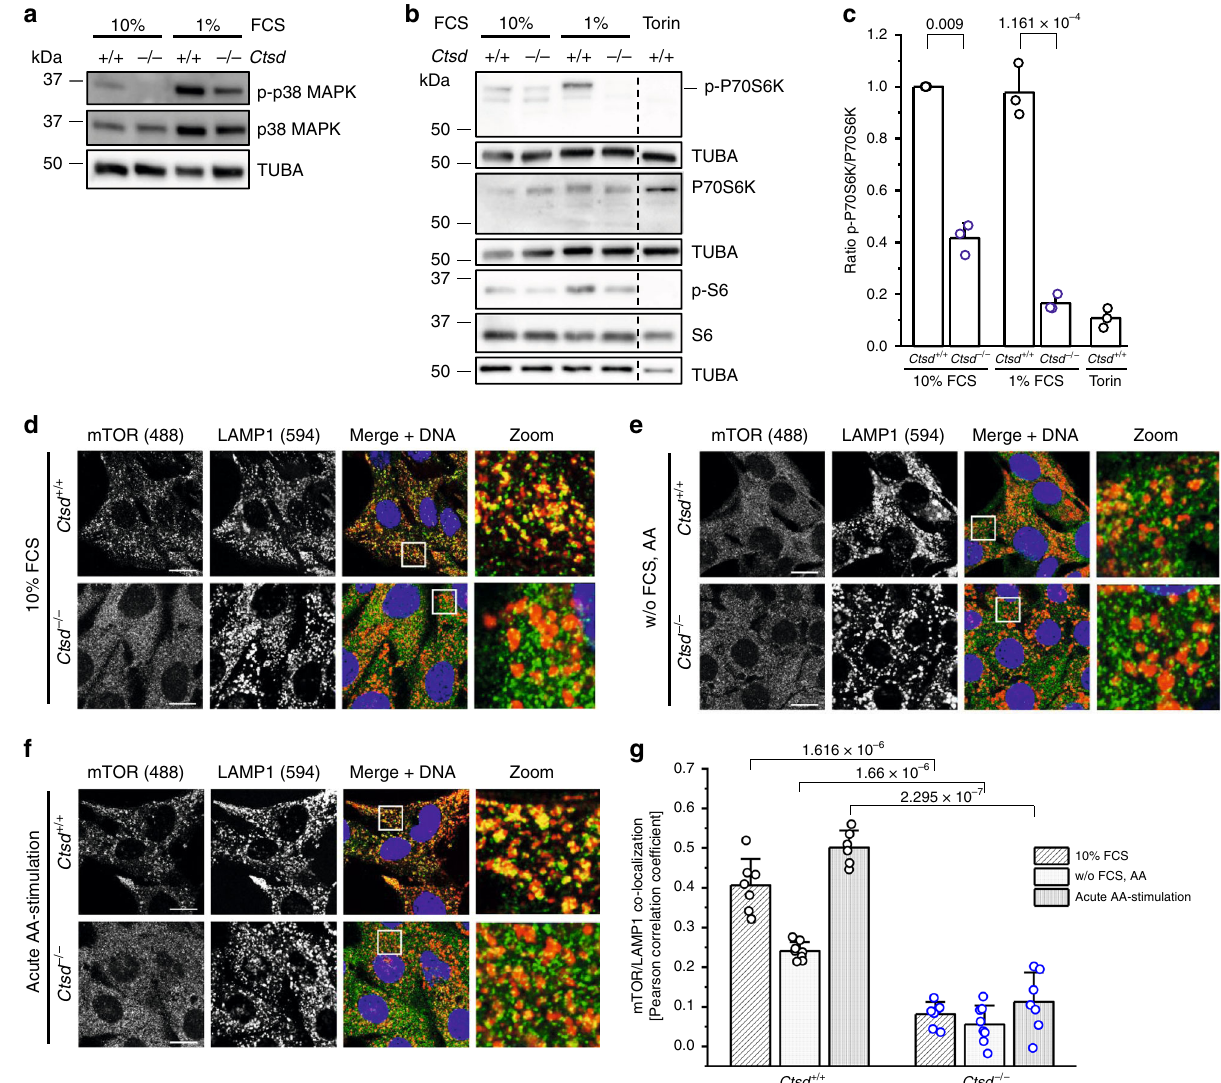
Fig. 6 CTSD de fi ciency impairs mTORC1 localization and activity at the lysosomal membrane. a Analysis of phosphorylated (p-p38 MAPK) and total p38 MAPK protein levels by Western blot (with TUBA as loading control) in Ctsd + / + and Ctsd − / − PyMT cells cultured for 7 – 10 days in 10% FCS or 1% FCS medium. Representative of 2 (p-p38 MAPK) and 1 (p38 MAPK) independent experiments. b Analysis of phosphorylated (p-P70S6K and p-S6) and total P70S6K and S6 protein levels by Western blot (with TUBA as loading control) in 10% FCS, 1% FCS, and mTOR inhibitor Torin-treated Ctsd + / + and Ctsd − / − PyMT cells. Representative of 2 ((p-)S6) and 3 ((p-)P70S6K) independent experiments. c Quanti fi cation of (p-)P70S6K Western blots as in b , plotted as p-P70S6K/P70S6K ratio relative to 10% FCS Ctsd + / + ( n = 3 independent experiments; two-sided one-sample and two-sample t -test). Pictures of 10% FCS ( d ), FCS- and amino acid (AA)-starved ( e ), and acutely AA-stimulated ( f ) Ctsd + / + and Ctsd − / − PyMT cells stained for mTOR (green), LAMP1 (red), and DNA (blue). Zoom shows enlargement of indicated image area in merge + DNA. Bars, 10 μ m. Representative of 2 independent experiments. g Quanti fi cation of mTOR/LAMP1 co-localization in d – f ( n = 6 images for acutely AA-stimulated Ctsd + / + , n = 7 images for acutely AA-stimulated Ctsd − / − and 10% FCS, n = 8 images for w/o FCS, AA; two independent experiments; two-sided two-sample t -test). Bar charts show all data points with mean + SD and p- value. Source data are provided as a Source Data fi heterozygosity (LOH). In general, all tumors exhibited low mice (Fig. 7b). Apparently, cancers found a way to escape the growth numbers of mutations, which con fi rms previous reports showing arrest imposed by CTSD de fi ciency after a two-month latency highest genomic stability of PyMT tumors among all investigated period — just to grow and metastasize seemingly undisturbed. Of breast cancer models 34 . Comparing the mutation types of note, also end-stage MMTV-cre;Ctsd − / − tumors were CTSD- de fi cient in their cancer cell compartment (Supplementary MMTV-cre;Ctsd − / − and control tumors, we did not observe major differences in frequency, except for intergenic mutations Fig. 1b). We hypothesized that MMTV-cre;Ctsd − / − tumors may have acquired oncogenic mutations during the long latency of (23 vs 11%) and the absence of splice region, non-coding, and tumor development. Therefore, we sequenced the whole exome of stop mutations in MMTV-cre;Ctsd − / − tumors (Fig. 7c). Circos plots showed that the majority of mutations were unique for one tumors from 18-week-old mice (Fig. 7c, d). We identi fi ed single individual and that tumors from MMTV-cre;Ctsd − / − mice on nucleotide variants (SNV) and small insertions or deletions (Indel) that arose through somatic mutations or loss of average did not have more mutations than the controls (Fig. 7d).